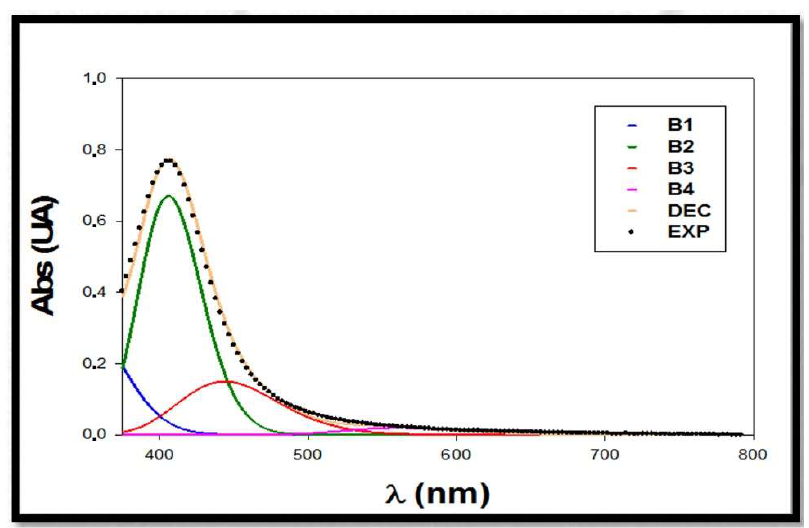
Figure 5. Deconvoluted spectra of a mixture citrate+PVP-AgNPs:Al, corresponding to an Al(III) concentration of 1 µ M. EXP: experimental spectra; DEC: deconvoluted spectra; B1: sample matrix band; B2: free silver nanoparticles in solution band; B3: silver nanoparticles interacting with Al(III) band; B4: aggregated silver nanoparticles band. Table 2. Deconvolution parameters of the bands corresponding to free silver nanoparticles in solution (B2) and silver nanoparticles interacting with Al(III) (B3). λ B2 max = 406 nm; λ B3 max = 444 nm. Al(III) ( µ M) in